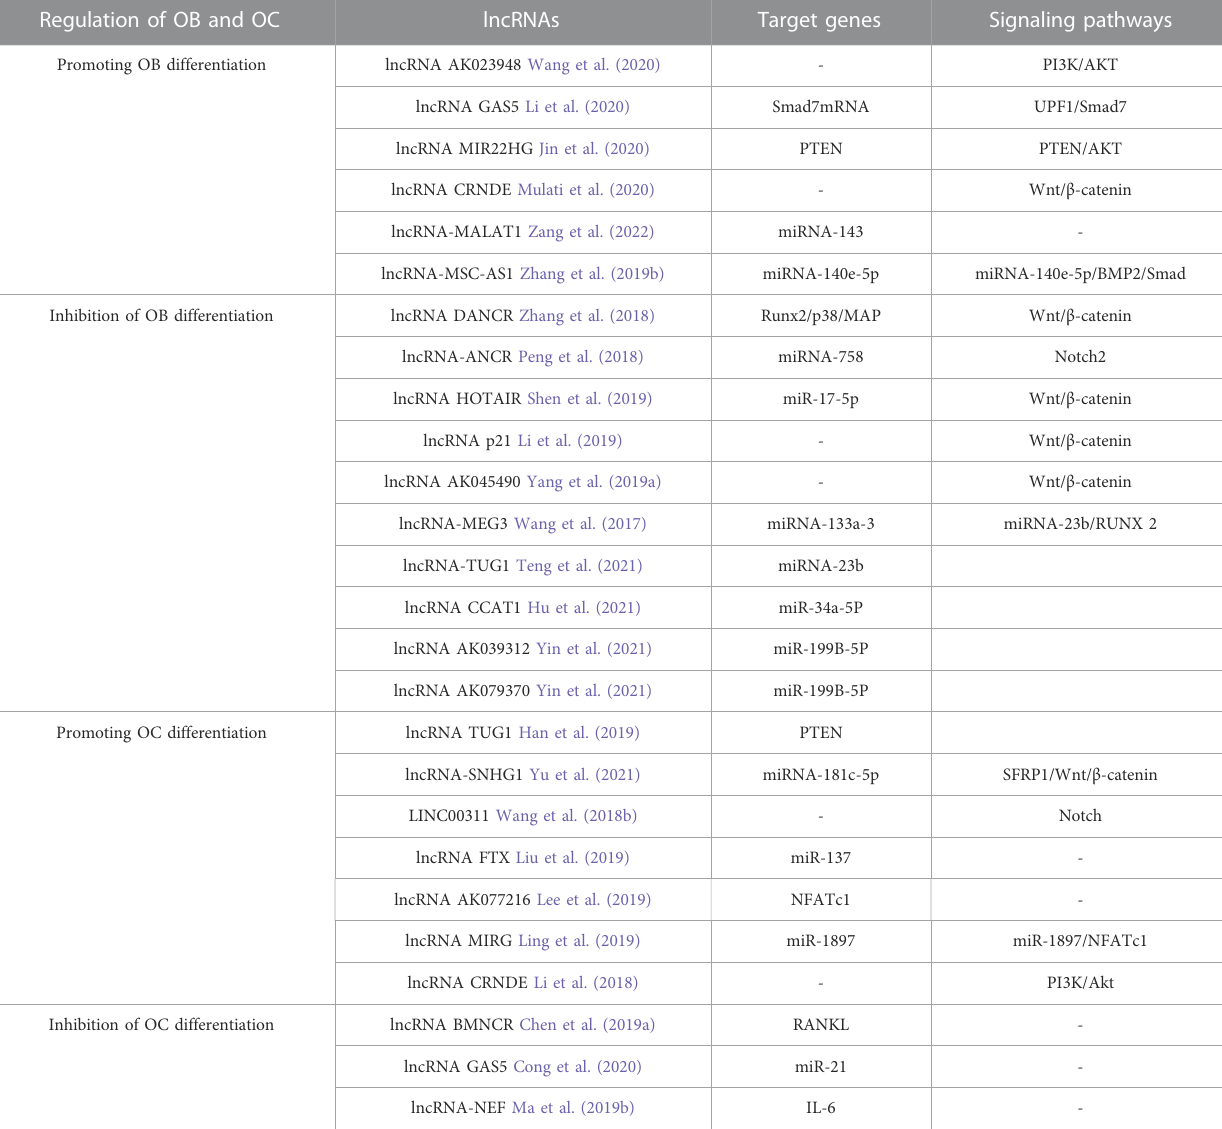
TABLE 4 lncRNAs are involved in controlling the process of bone formation and